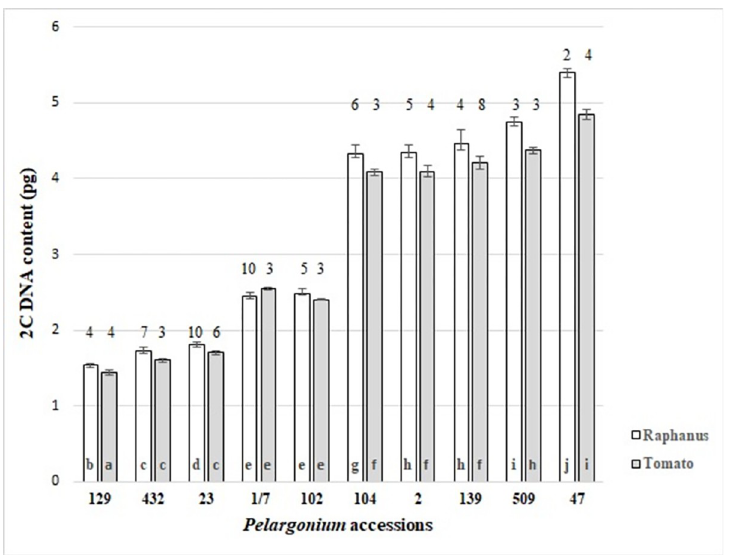
between the ploidy level of the accessions and their 1C x genome size was not found (Fig 3). The lowest 1C x DNA content was found for the octoploid accession P . graveolens 666 (0.47 pg) and the highest for the diploid P . tabulare 29 (0.66 pg) (Table 1). Averaging the 1C x values over their ploidy level (Table 3), there is an increase from the dip- loid over the tetraploid species to the hexaploid species, but a significant decrease of mean 1C x